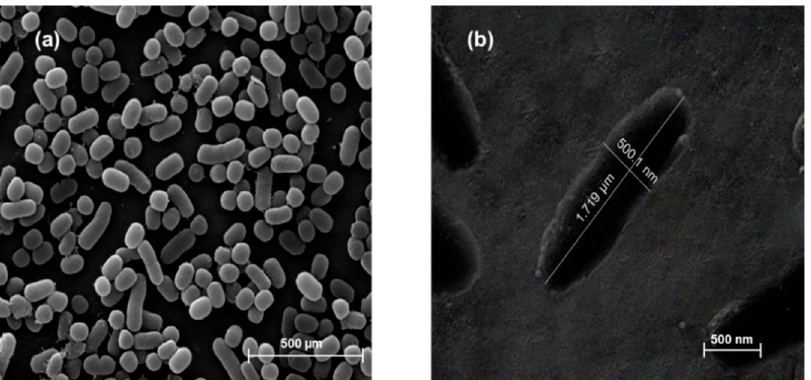
Figure 3. ( a ) Magnified SEM image at 10,000×; ( b ) the surface of whole K. pneumoniae on the SPE, with a size of approximately 0.5 × 1.7 µm (SEM image at 50,000×).